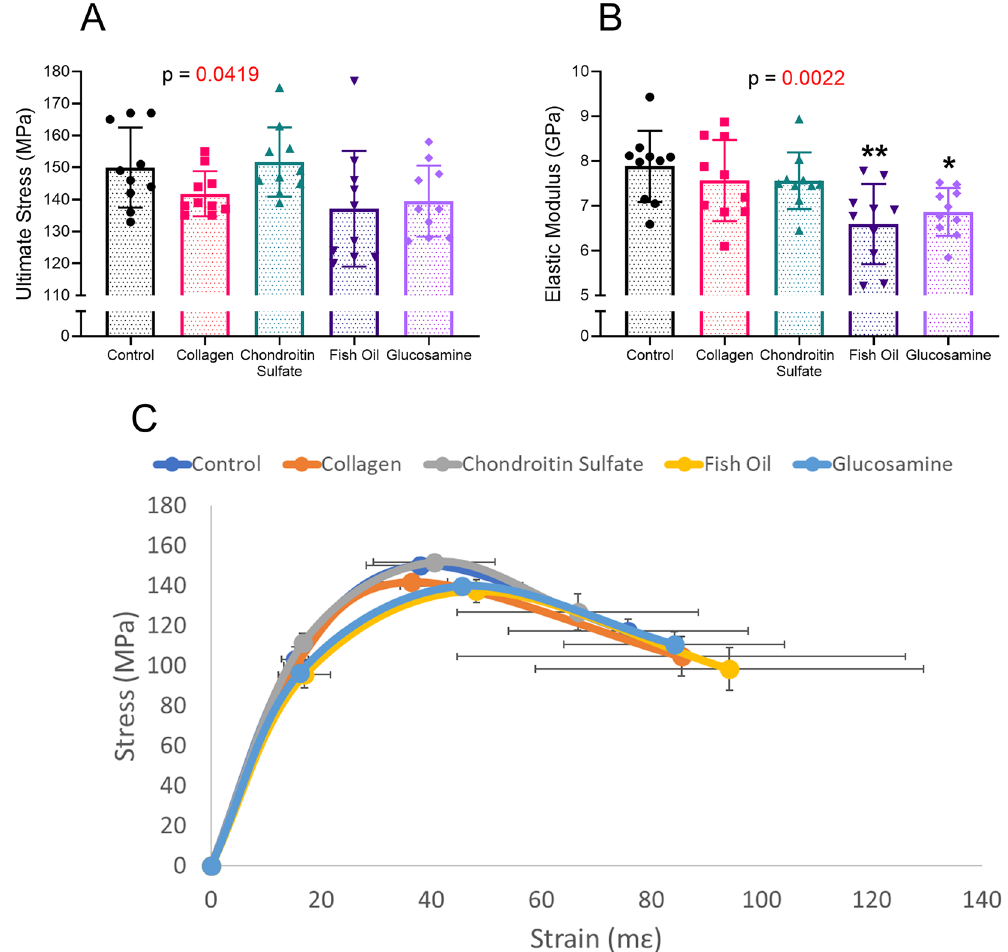
Figure 1. Mechanics of the femur. Ultimate stress ( A ), elastic modulus ( B ) and schematics of stress–strain curves ( C ). Overall ordinary one way ANOVA or Kruskal Wallis p values are listed above the graph. Asterisks indicate significance when the individual group below was compared to the control group in a posthoc analysis with * = p = 0.0169, ** = p =